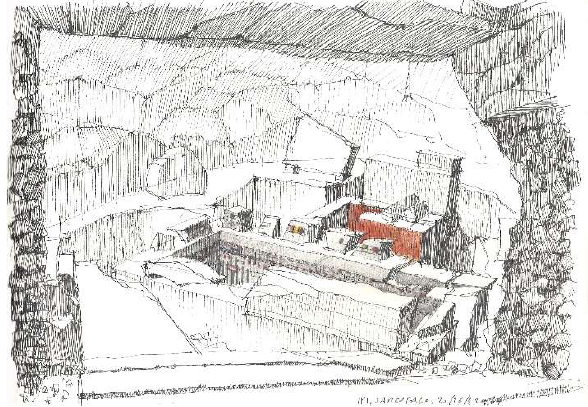
Figure 4. View of Ipi’s sarcophagus chamber.